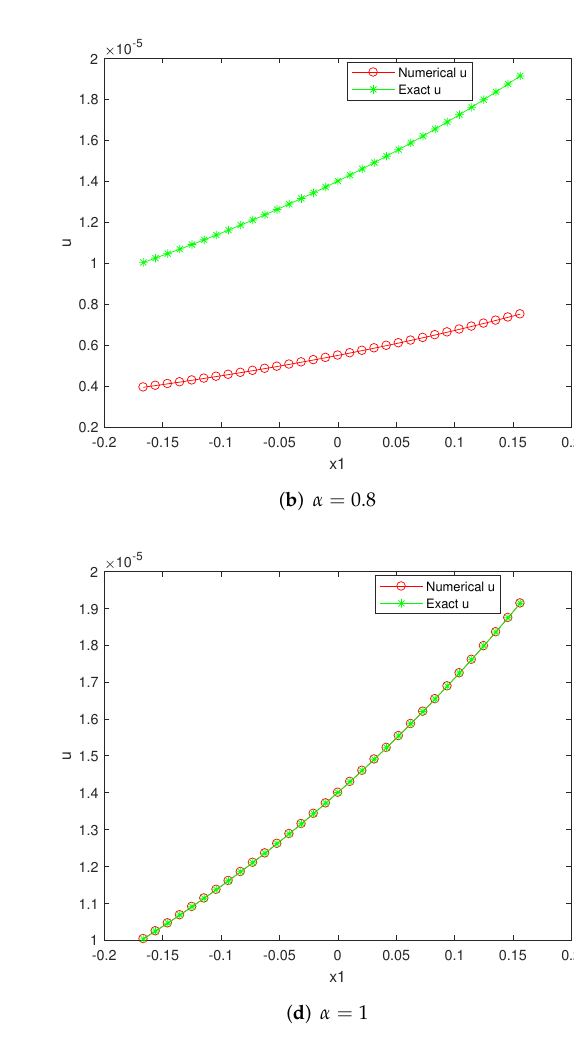
Figure 3. Example 1. Comparison of the numerical solutions and the exact solutions in Equation (84) at the end time for different fractional order α with x 2 = 1/24, y 1 = 1/12, y 2 = 3/24. Example 2. A bounded periodic (4+1)-dimensional time-fractional Fokas equation based on Equa- tion (11) can be given